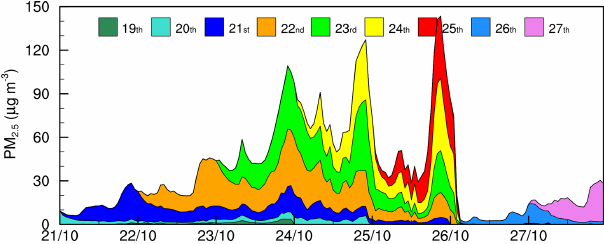
Figure 3. Cumulative contributions to PM 2 . 5 concentrations in Bei- jing from emission changes on successive days. Each contribution was generated with a separate model run applying 30%–50% emis- sion changes, matching APEC emission controls, over the three source regions for a single